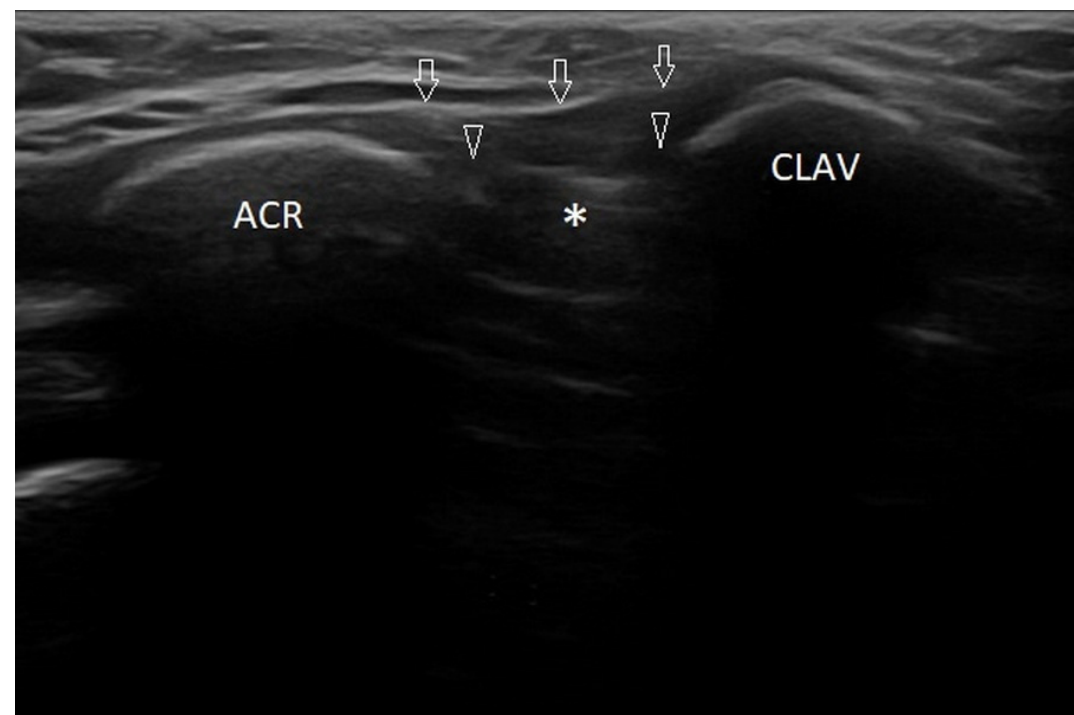
Figure 1. Longitudinal scan of the hip joint of a 5-year-old girl. Between the arrowheads—hyaline cartilage of the femoral head; arrow—level of the growth plate of the femoral head; asterisk—the labrum. Linear probe 3–12 MHz.